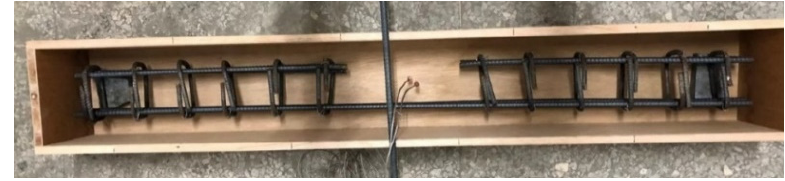
Figure 3. The configuration of the steel rebar and thermocouple.